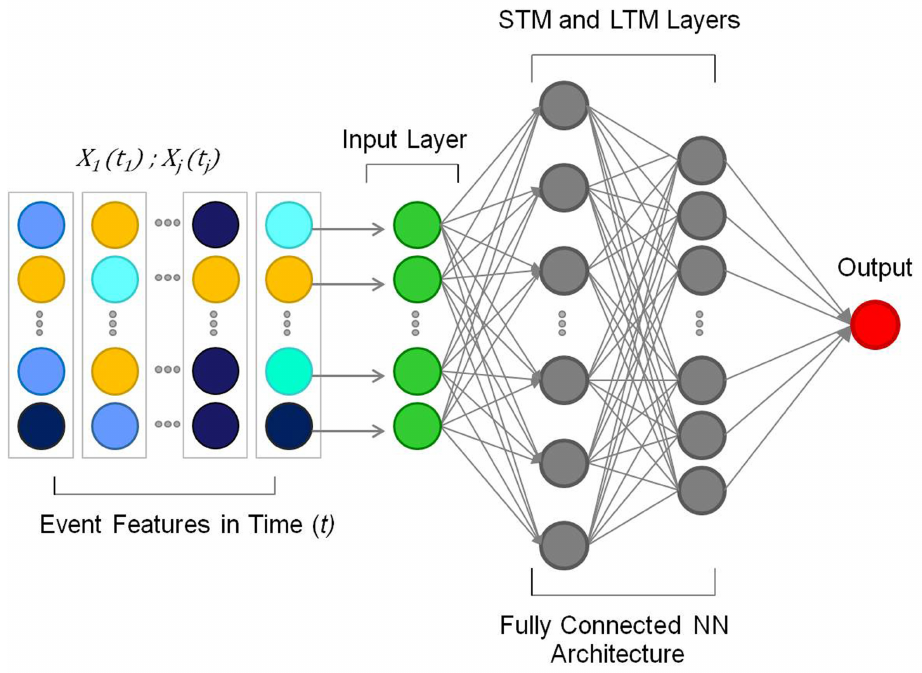
Figure 3. ART-inspired neural network architecture for adaptively intelligent event coding across time t.